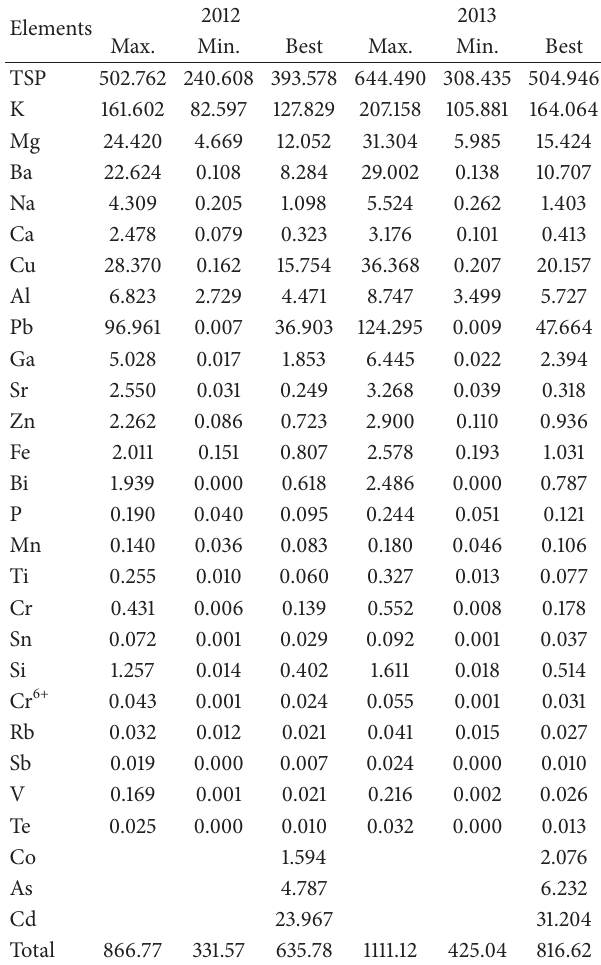
Table3:Correlationbetweenelementsoverthestudyperiodin2012 Table 4: Estimated emissions of trace metals from the BFF during the study periods (in